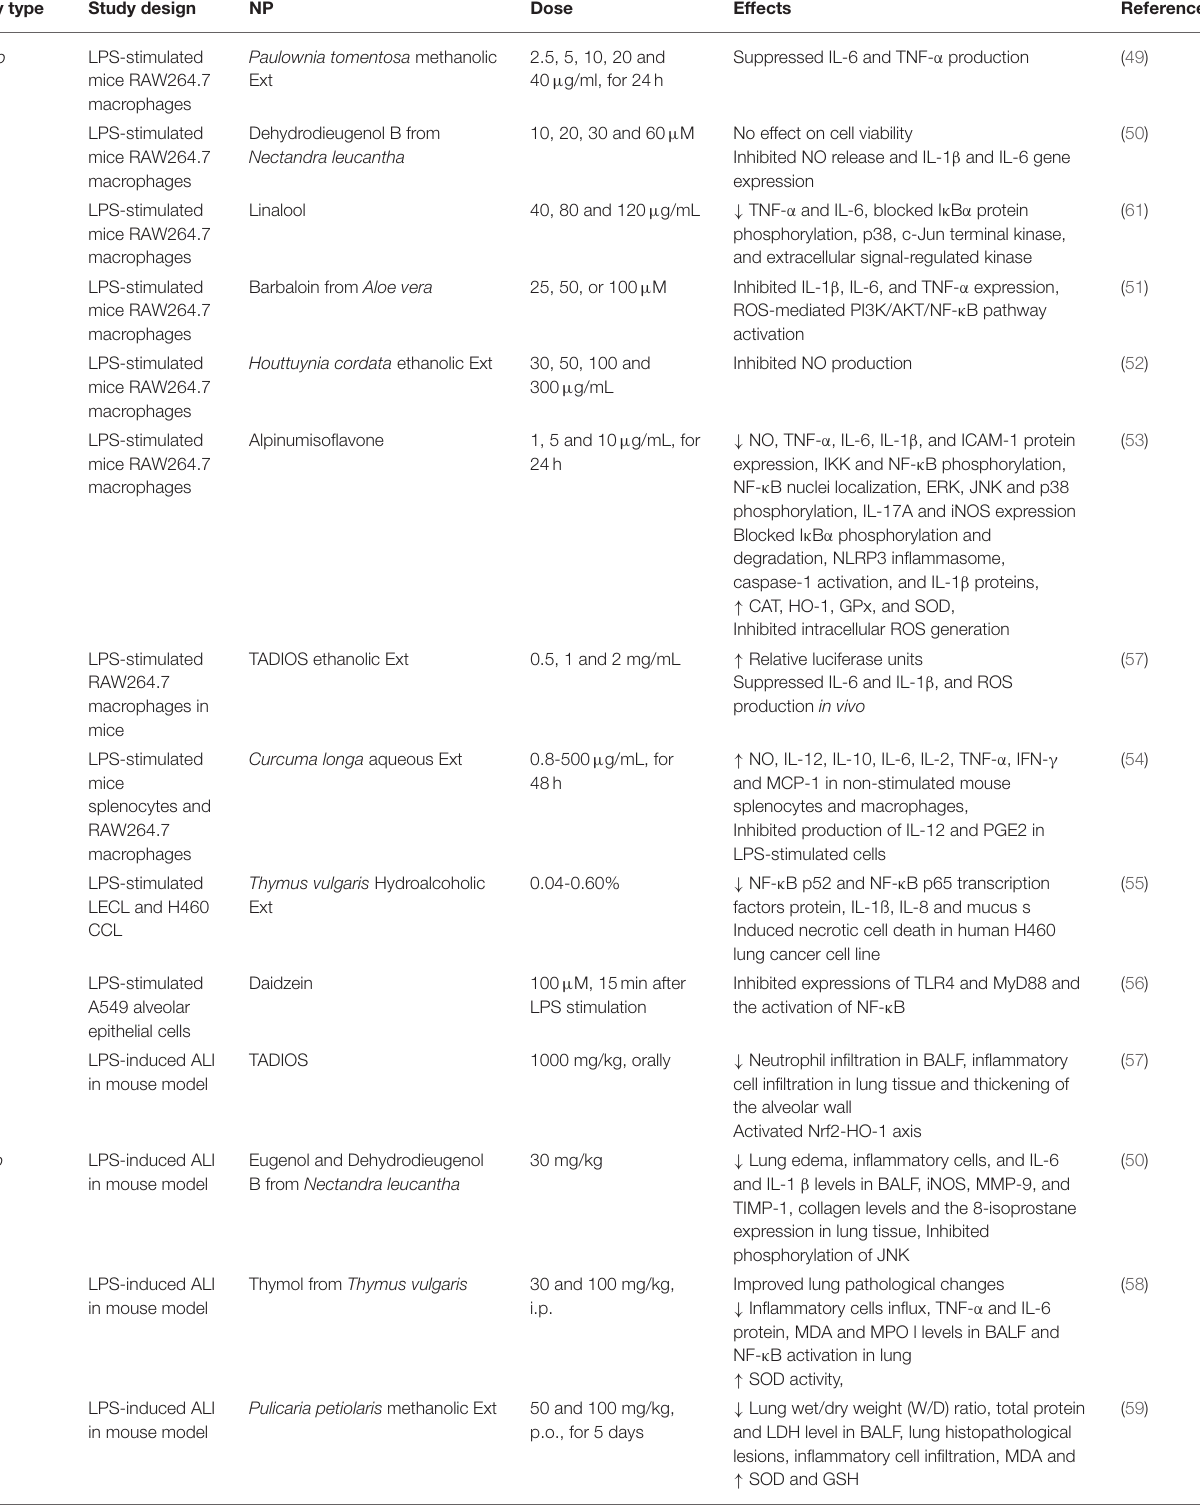
TABLE 4 | The possible therapeutic effects of medicinal herbs in the LPS-induced lung disorders in experimental studies. Study